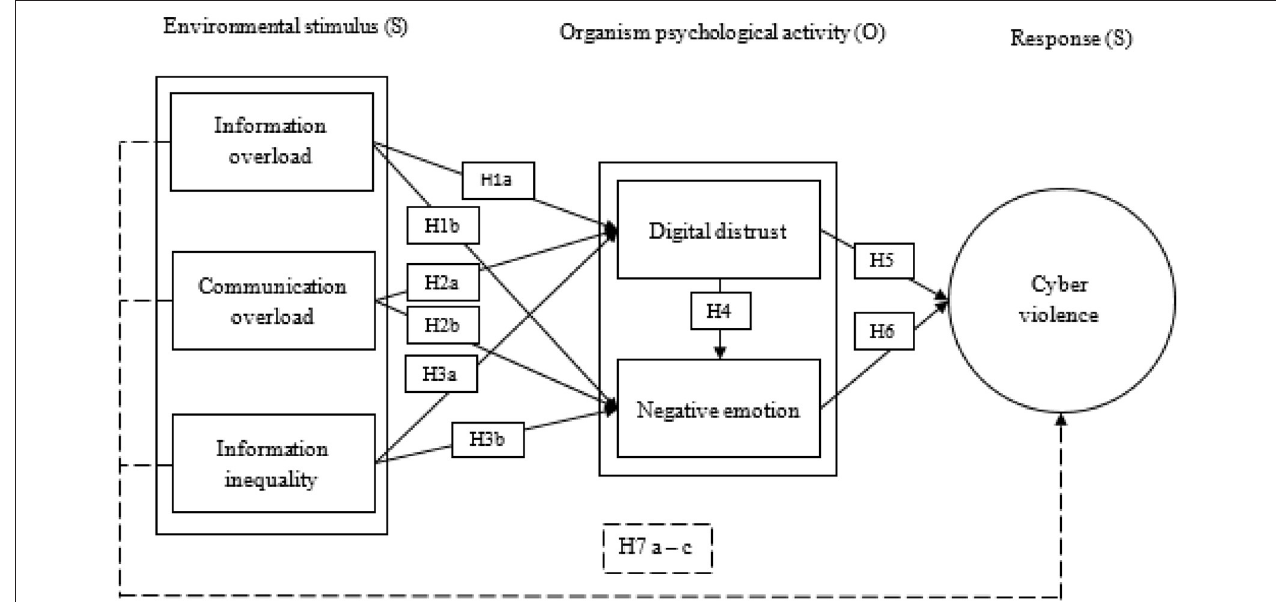
FIGURE 1 | Theoretical